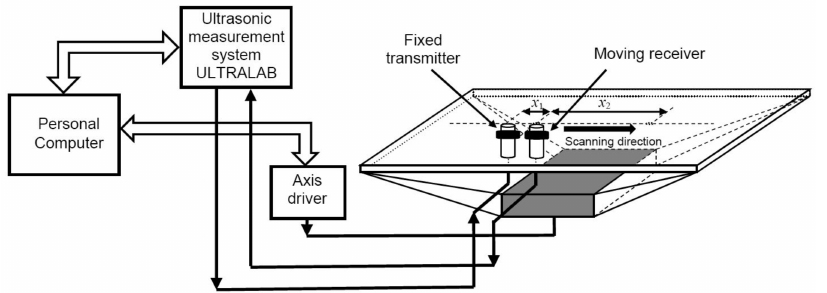
Figure 5. Experimental setup of the generation and recording of the Lamb waves signals propagating in PVC